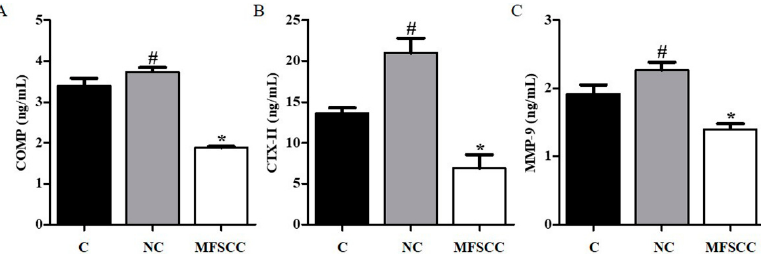
Figure 5. Biomarkers of cartilage degradation in a rat OA model. Expression of MMP-9, CTX-II, and COMP-2 in rat serum was analyzed by ELISA in a rat OA model ( A – C ). (C: injected with saline, NC: injected with MIA, and MFSCC: after 2 weeks of MIA injection, injected with MFSCC once a week for 3 weeks) The data are indicated as mean ± SEM (# p < 0.05 compared with the control group; * p < 0.05 compared with the NC group).